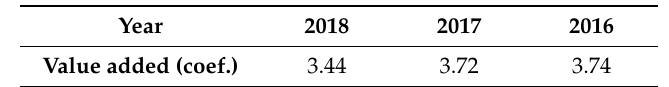
Table 3. Value added in individual